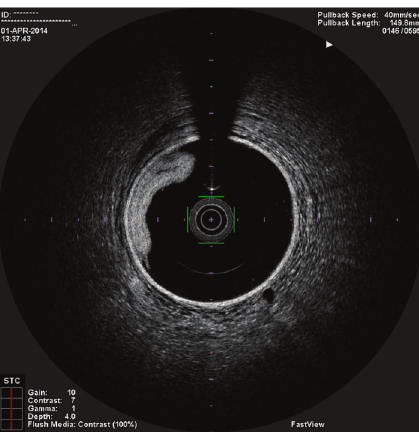
Figure 1: OCT image showing the guidewire in the false lumen as the true lumen is crushed against the vessel wall.